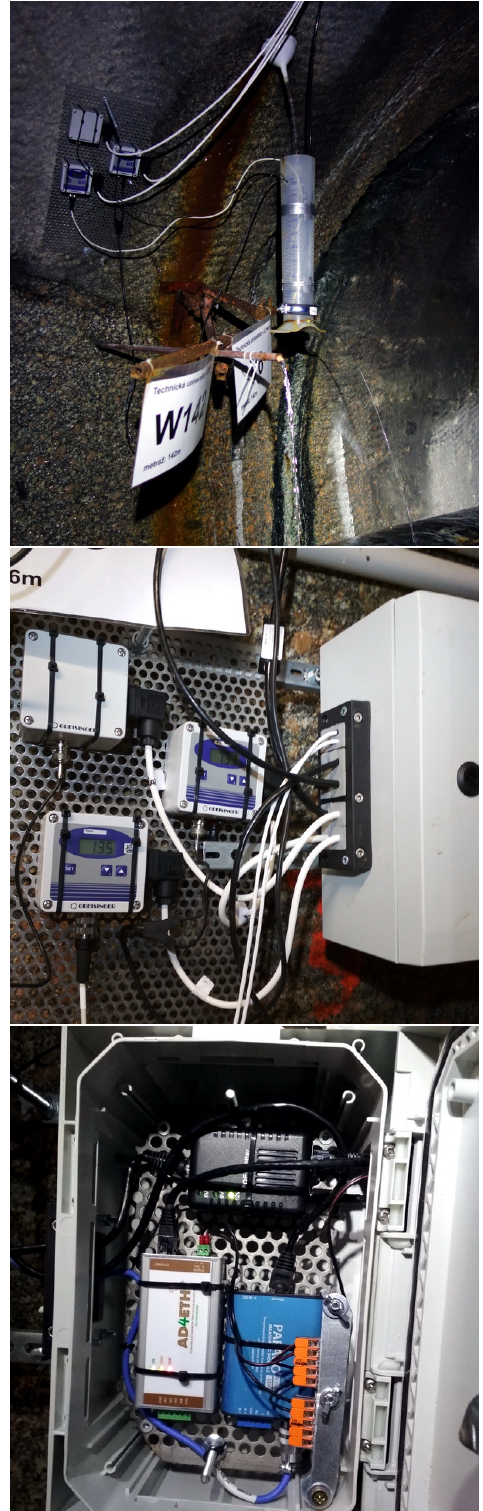
Fig. 7. Complete equipment of the automatic measurement. Up: V6 discharge with probes. In the middle: cables leading from probes directly or trough Greisinger [17] transmitters into the water resistant box. Bottom: the box containing the PoE splitter, the A / D converter for general quantities and the Papouch A / D converter (here with its own PoE and the temperature sensor).